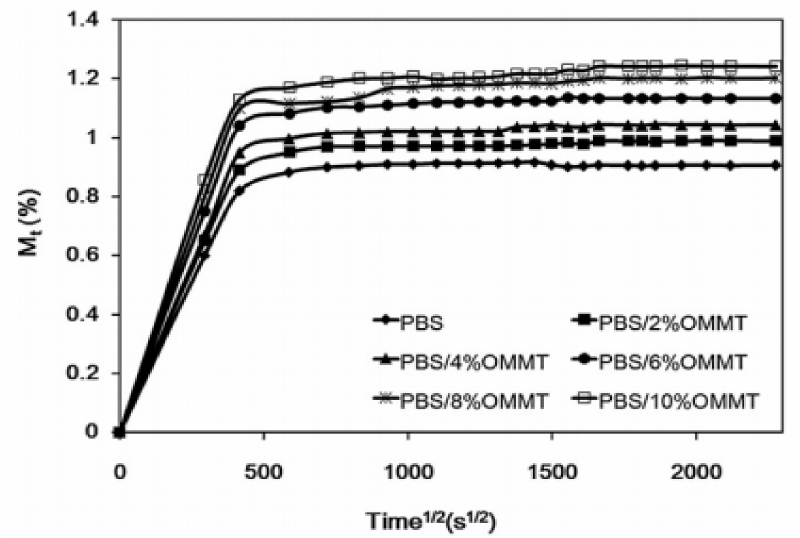
Figure 11. Typical moisture uptake curves at 30 C and 90% RH [72]. Adapted with permission from Nam et al.